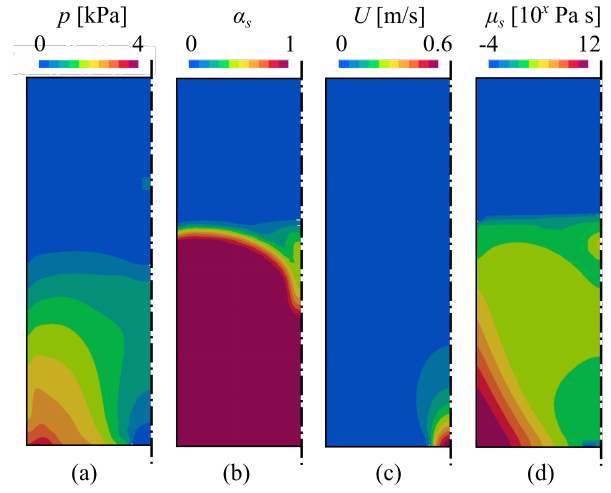
Figure 6. Silo discharge for Test 1 after t = 10 seconds showing: (a) Pressure field , (b) Solids fraction, (c) Velocity magnitude and (d) Solids viscosity (in log 10 scale).